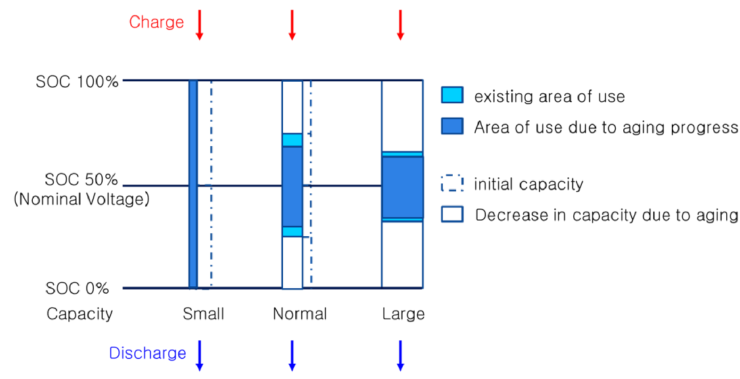
Figure 2. The difference in aging progress rate according to the area of use of series-connected